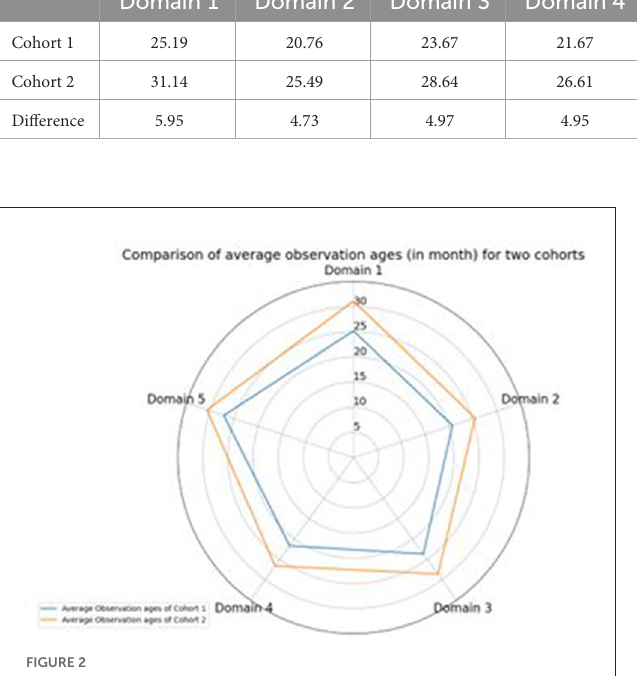
FIGURE2 Radar chart for average observation ages of two